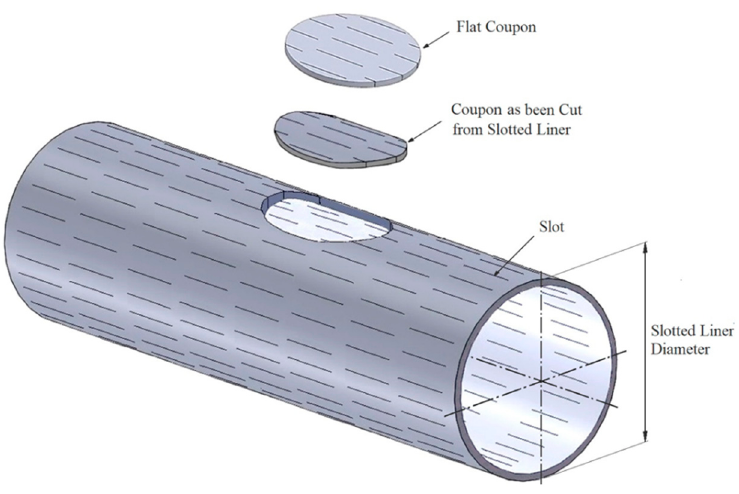
Figure 6. The multi-slot coupon obtained from a section of the 7-inch diameter slotted liner.